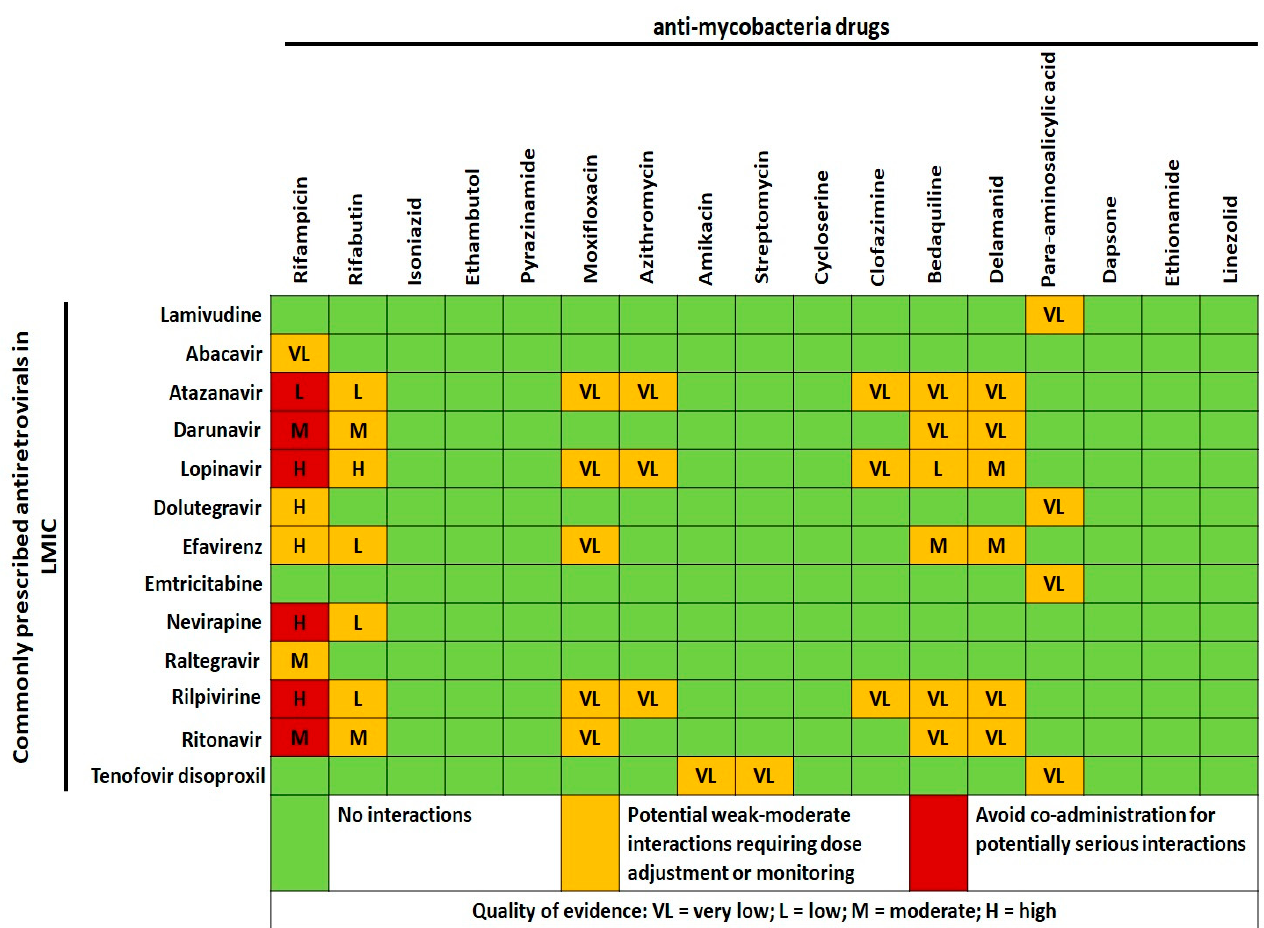
Figure 3. Cross-tabulation of drug–drug interactions between anti-mycobacteria drugs, including newest molecules against multi- and extensively drug-resistant mycobacteria, and antiretrovirals commonly prescribed in low and middle-income countries (LMIC). Data and quality of scientific evidence were extrapolated from the HIV Drug interaction checker online tool, University of Liverpool (https://www.hiv-druginteractions.org/checker; last access date 20 July 2021). Despite dolutegravir (DTG) roll-out in LMIC, efavirenz (EFV)-based cART is